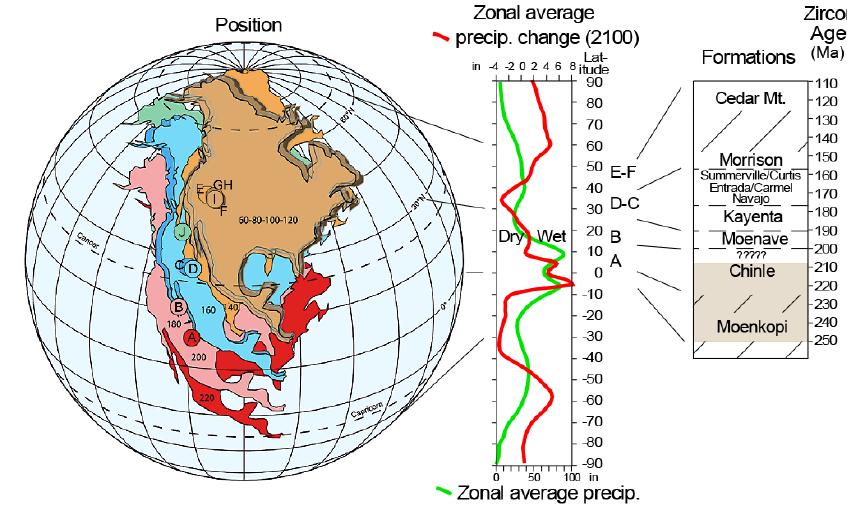
Figure 4. Position of North America (from Kent and Irving, 2010) and the Colorado Plateau (circles) from 220Ma to Present with com- parison to zonally averaged precipitation for today (1950–2000, from https://www.gfdl.noaa.gov/will-the-wet-get-wetter-and-the-dry-drier/, last access: September 2018), change in precipitation for 2100 (ibid.), and the zircon ages for formations (from core CPCP-PFNP13-1A for the Moenkopi and Chinle formations; Suarez et al., 2017 for the Moenave Formation; Marsh et al., 2014 for the Kayenta Formation; Trujillo et al., 2014 for the Morrison Formation; and Mori, 2009 for the Cedar Mountain Formation), with the interval spanned by the CPCP-PNF13 cores shown in tan (hachures indicate hiatuses). This shows how relatively small northward translation of western North America during the Triassic could result in strong changes in climate sensitive